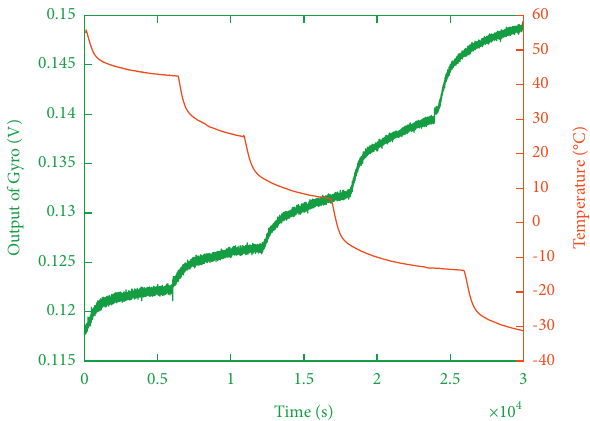
Figure 9: Temperature test results.